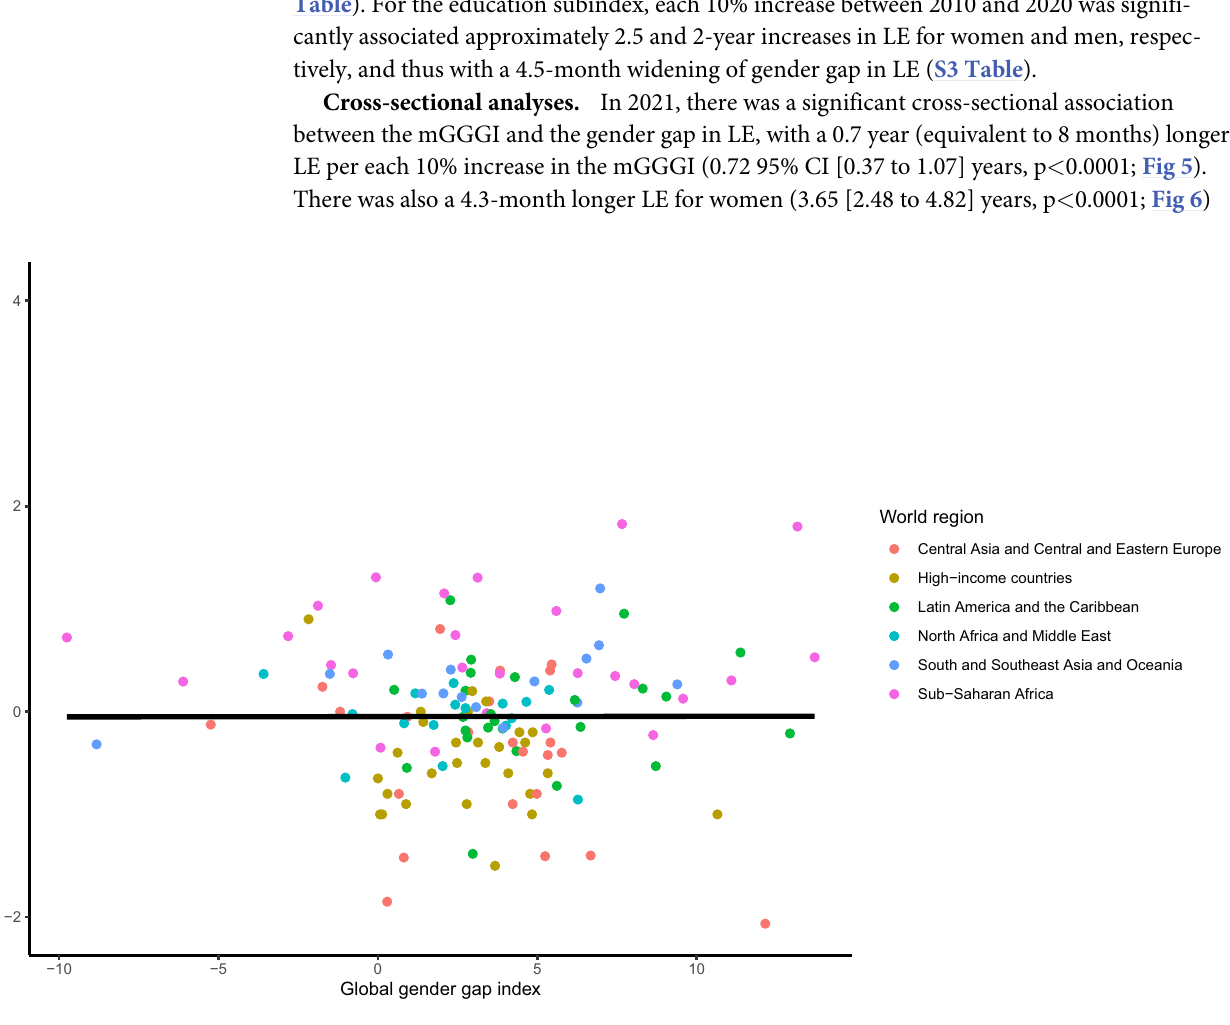
Fig 2. Association between change in the mGGGI and change in the gender gap in life expectancy between 2010 and 2020. The scatterplot displays the linear regression line for the association between the change in the mGGGI and the change in gender gap in life expectancy (0.00 [-0.29 to 0.30], p-value 0.985).